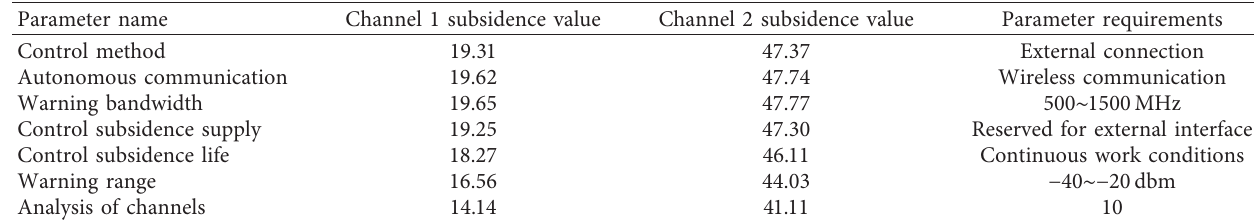
Table 4: Analysis of autonomous control of safety early